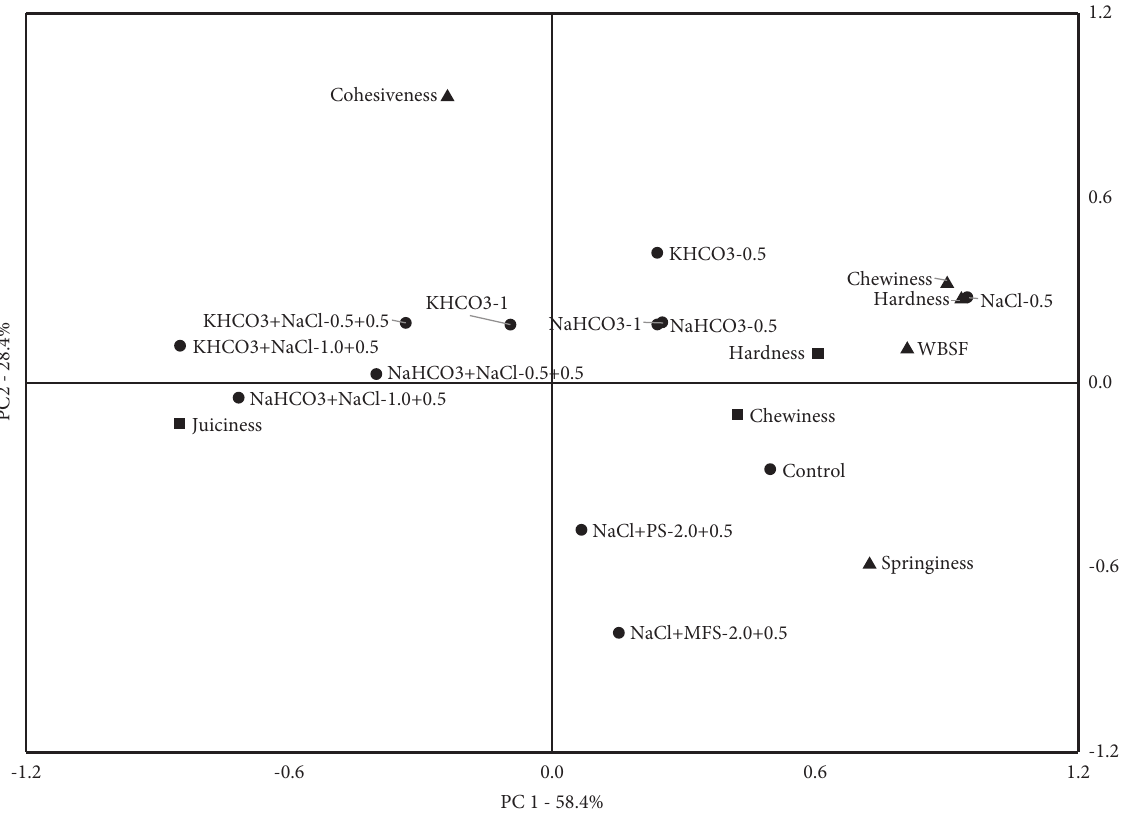
Figure 3: PCA biplot showing the relationship between the instrumental texture data ( ▲ ) and sensory attributes ( ▪ ) and the treatment ( ● ) positions in relation to both set of